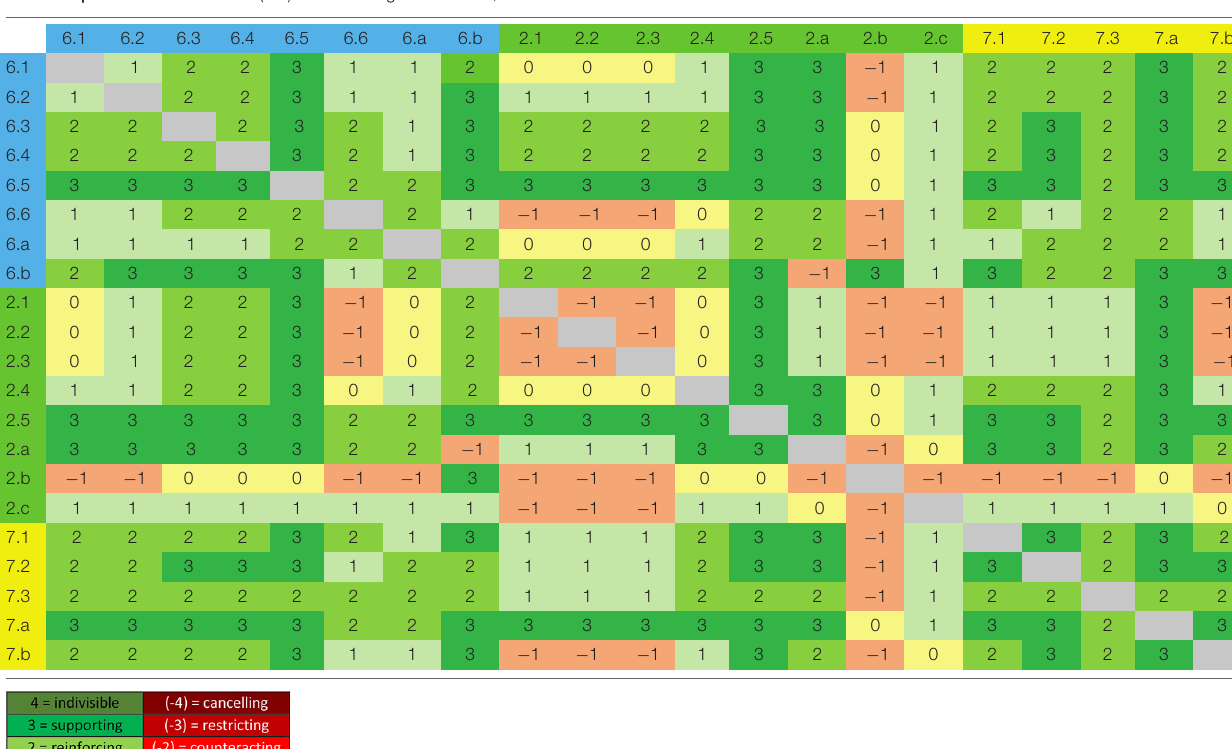
TABLE 3 | Total interaction score ( TIS ) between targets of SDG 2, 6 and